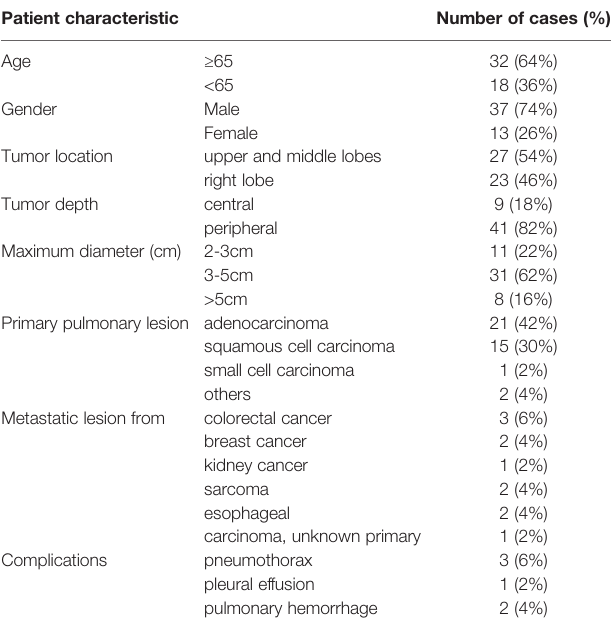
TABLE 1 | Patient demographic and clinical